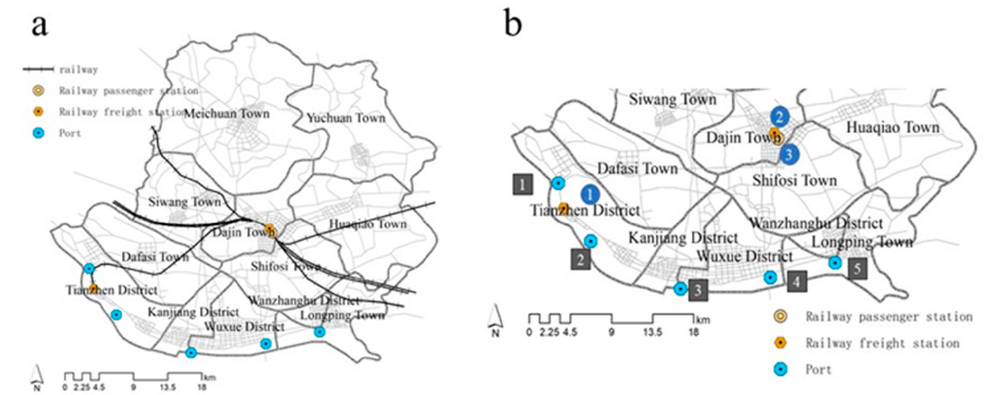
Figure 15. Water-land transport network. ( a ) Railways and port planning. ( b ) Railway stations and port serial numbers.